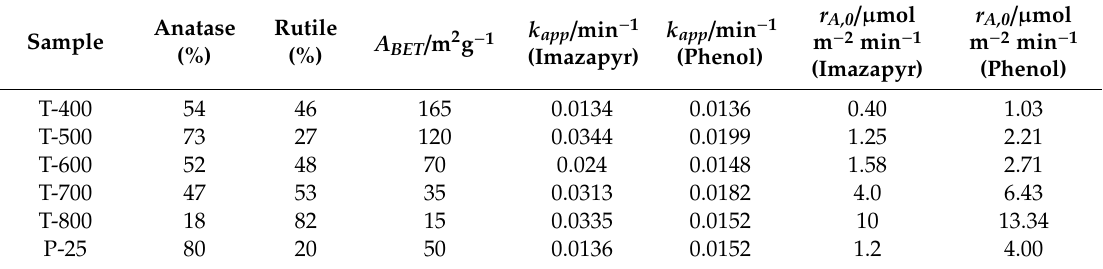
Table 1. Textural properties of mesoporous TiO 2 calcined at 400 ◦ C, 500 ◦ C, 600 ◦ C, 700 ◦ C, and 800 ◦ C and commercial P-25 and their photocatalytic